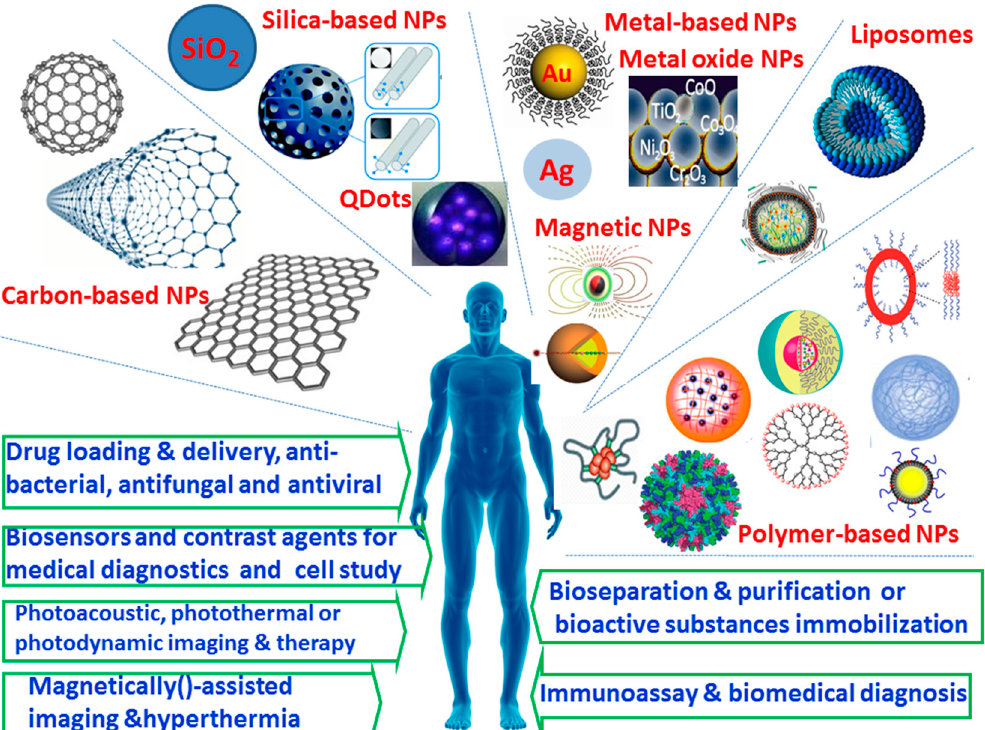
Figure 2. Examples of typical nanoparticles and their applications in biomedical